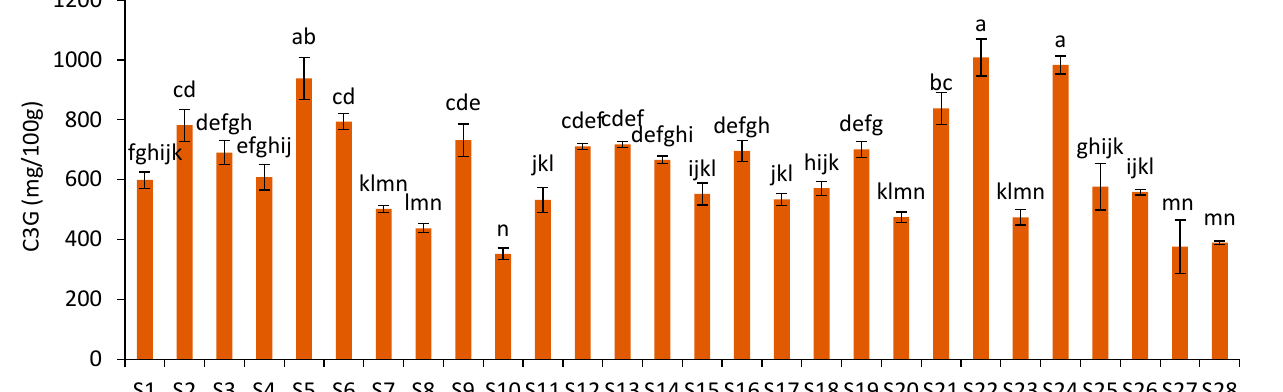
Figure 3. Cyanidin-3- O -glucoside content in different JPF samples. Different letters in different samples correspond to significantly different values ( p < 0.05).